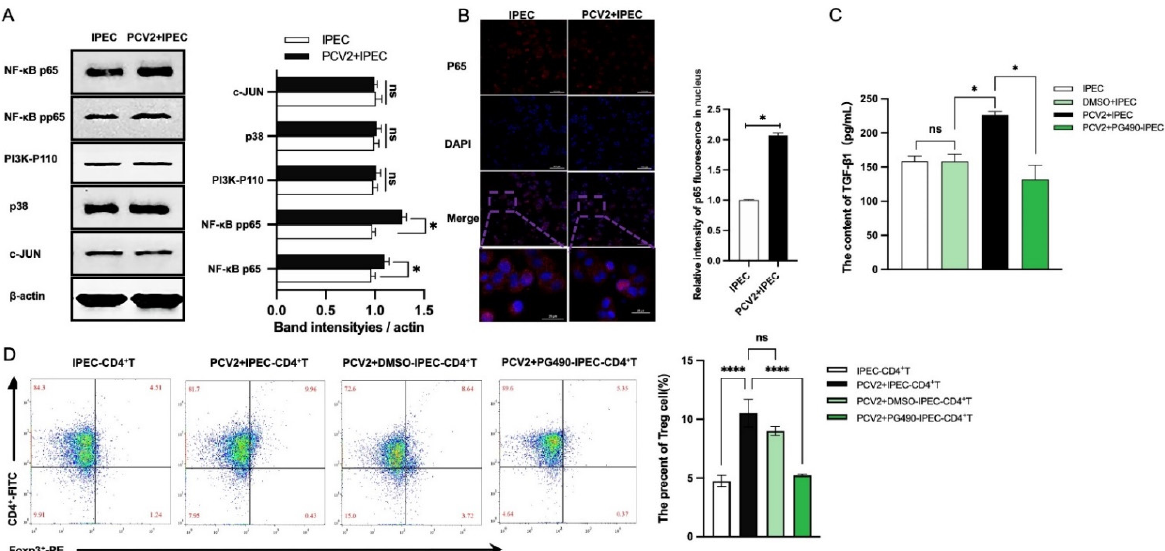
Figure 5. The increase in the number of Tregs caused by PCV2-infected IPEC-J2 is dependent on the activation of NF- κ B in IPEC-J2. Western blotting was used to test the protein expressions of p110 (PI3K- p110), total p38, c-JUN, NF- κ B p65 and the phosphorylated NF- κ B p65 (NF- κ B pp65). The expression of each protein was quantified using ImageJ and normalized to β -actin levels ( A ). A confocal laser was used to detect the p65 in the nucleus of a CD4 + T cell and quantified by ImageJ ( B ). The production of TGF- β from IPEC-J2, IPEC-J2 treated with DMSO, PCV2-infected IPEC-J2 and IPEC-J2 treated with 20 μ M PG490 (inhibitor of NF- κ B) was detected by ELISA (C). The IPEC-J2 from ( C ) was co-cultured with a CD4 + T cell, and the percentage of Treg cells was tested by flow cytometry after 3 days ( D ). All assays were performed in triplicate, with three technical repeats for each sample. **** p < 0.0001; * p < 0.05; ns, No Significant. Next, we analyzed the effect of NF- κ B in IPEC-J2 on CD4 + T cells. IPEC-J2 were treated with NF- κ B inhibitor (PG490) for 12 h prior to infection with PCV2 and co-cultured with CD4 + T cells. After 3 days, the frequency of Treg cells was considerably reduced in IPEC-J2 treated with an NF- κ B inhibitor compared with the PCV2-IPEC+CD4 + group and the DMSO group (the vehicle) (Figure